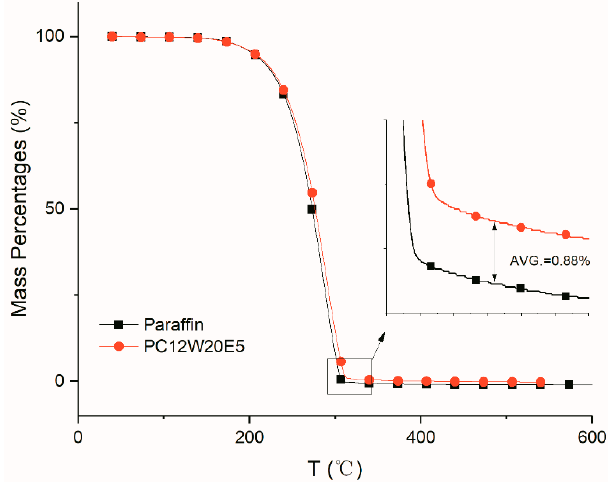
Figure 12. TGA curves of paraffin and PC12W20E5.